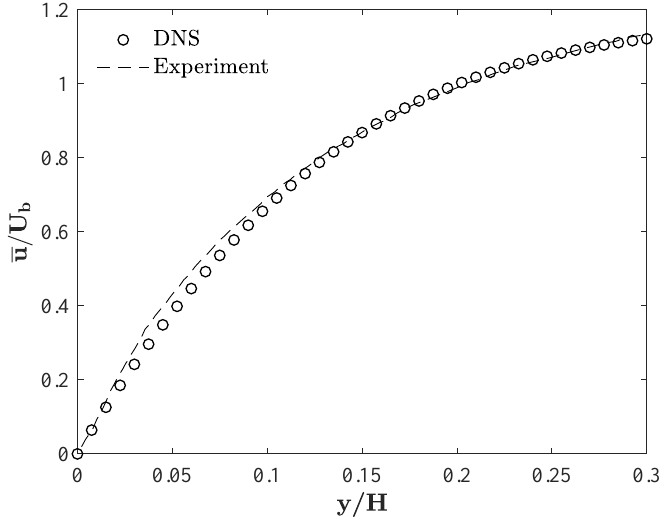
Figure 1. Comparison of the mean axial velocity profiles ( u / U b ) with the experimental study of Shaban et al. (2018)